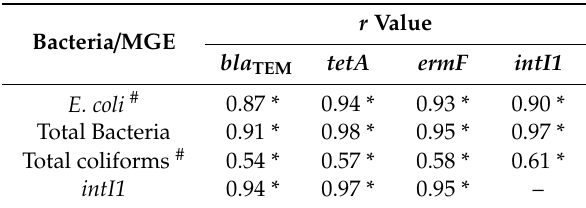
Table 2. Correlations among total bacteria, E. coli , ARGs, and intI1 .